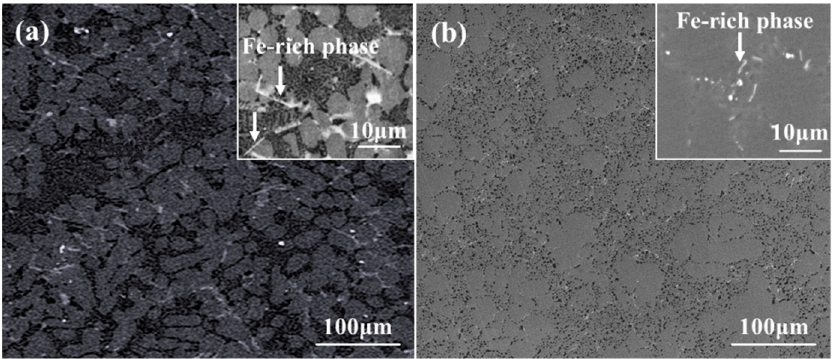
Figure 6. Morphology of the Fe-rich phase of the alloy formed by squeezing casting: ( a ) as-cast sample, ( b ) sample after experienced solution treatment.